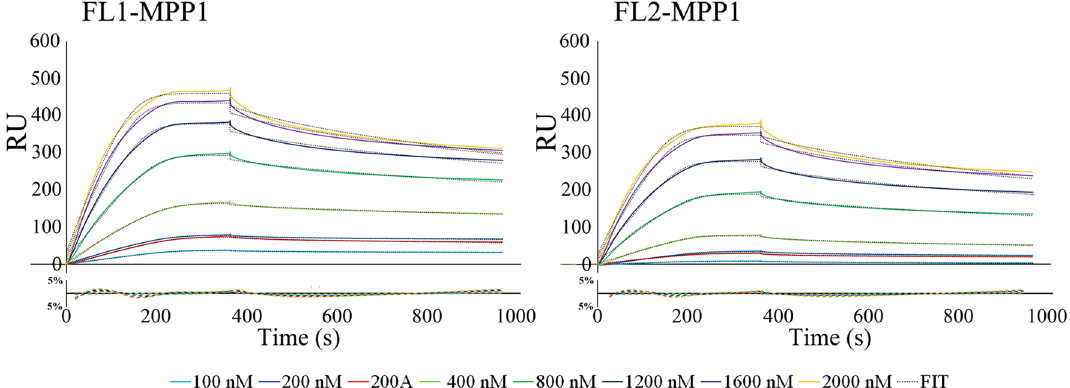
Figure 2. Recombinant MPP1 binds recombinant flotillin 1 or flotillin 2 with equilibrium dissociation constant, K D , values in nanomolar range. HIS-tagged flotillins were immobilized on the Ni–NTA chip and its interaction with full-length recombinant, untagged MPP1 (series of concentration 0–2000 nM) was analyzed by SPR using a BIAcore T200. Black dotted lines represent fitted 1:1 Langmuir binding model. Residual plots beneath every sensorgram series were evaluated for systematic divergences from the fitting curves. Other details in “Materials and methods”